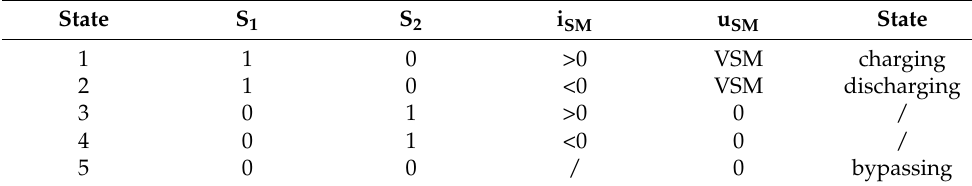
Table 1. Switch status of MMC-BESS.